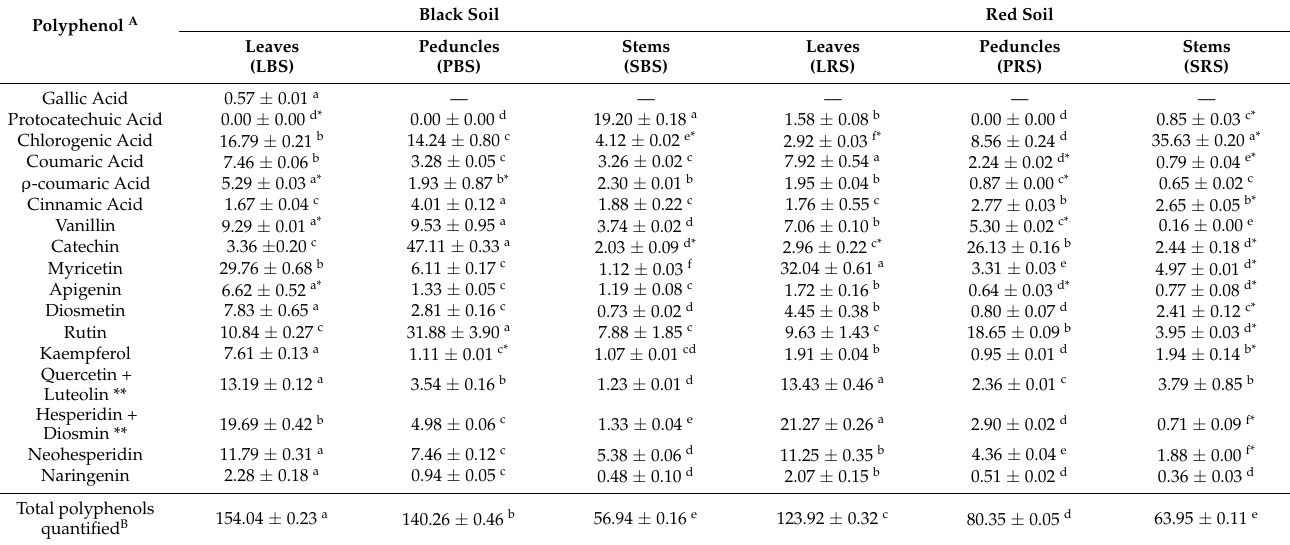
Table 1. Polyphenols content in chile habanero by-products extracts of plants grown in black and red soils of Yucat á n, M é xico.